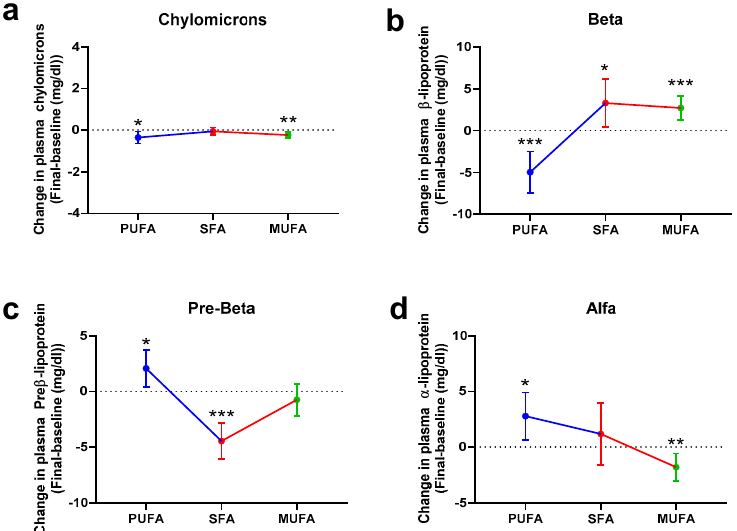
Figure 4. Changes in chylomicrons ( a ), beta ( b ), pre ‑ beta ( c ), and alfa ( d ) lipoprotein fractions attending to their mobility after 30 days of intervention with the different breakfasts. Data represent estimated treatment differences (final ‑ baseline) values and the 95% confidence interval (CI). Data derive from those women who completed the study ( n = 53). * represents differences within the same group (final ‑ baseline). * p < 0.050, ** p < 0.010, *** p < 0.001. No statistically significant difference